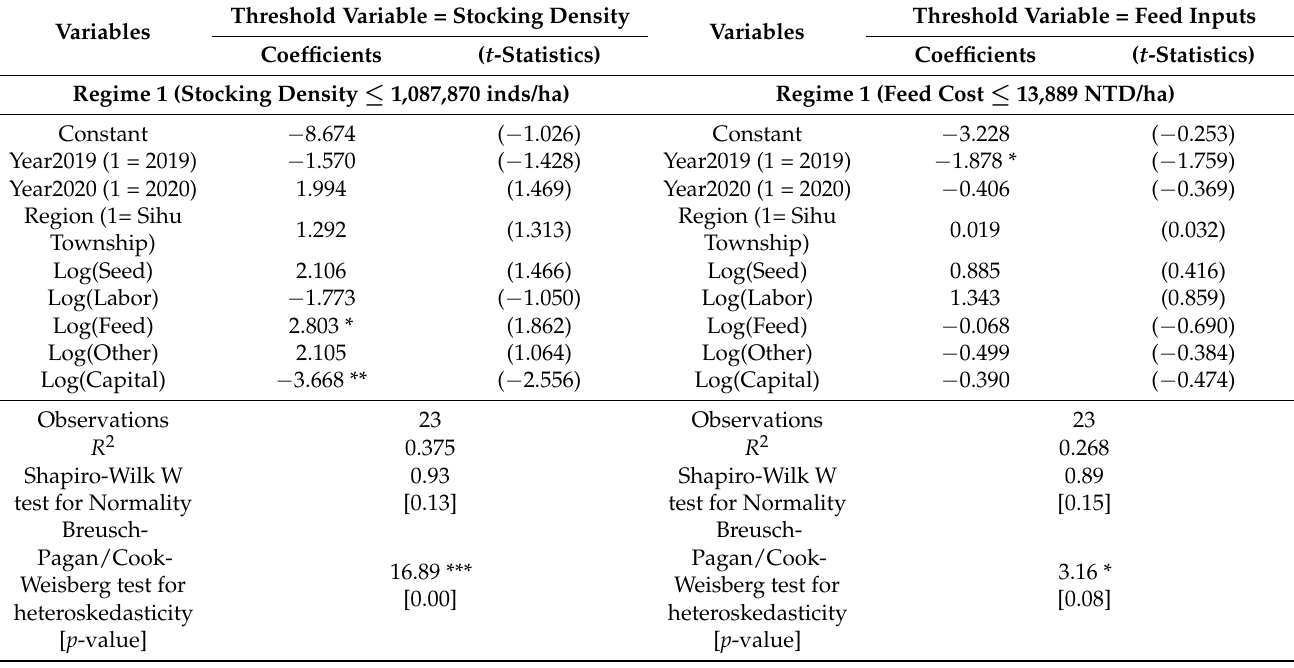
Table 2. Coefficient estimates of Cobb–Douglas production function for hard clam farming using different threshold